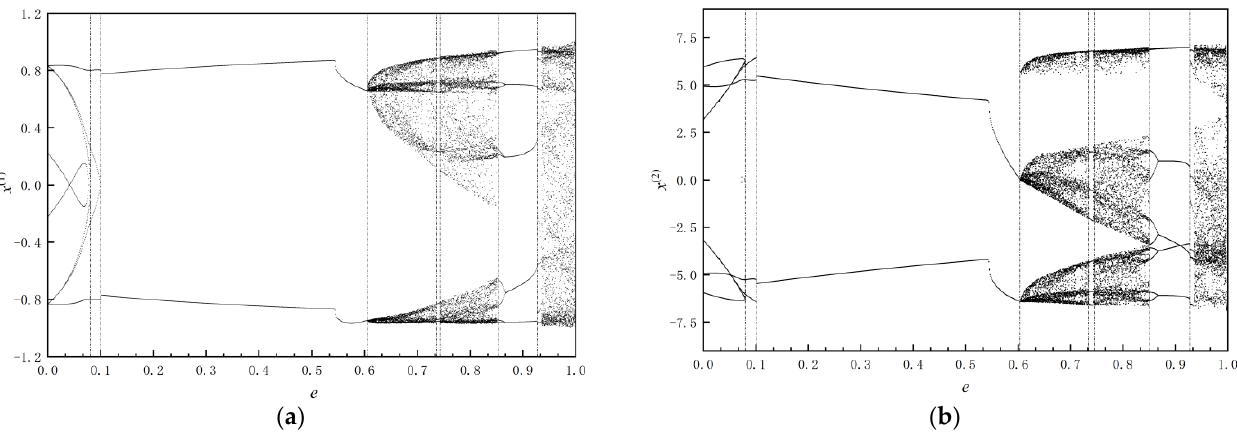
Figure 5. Bifurcation diagram of gear system. ( a ) Switching displacement of gear 1 ( b ) Switching displacement of gear 2.